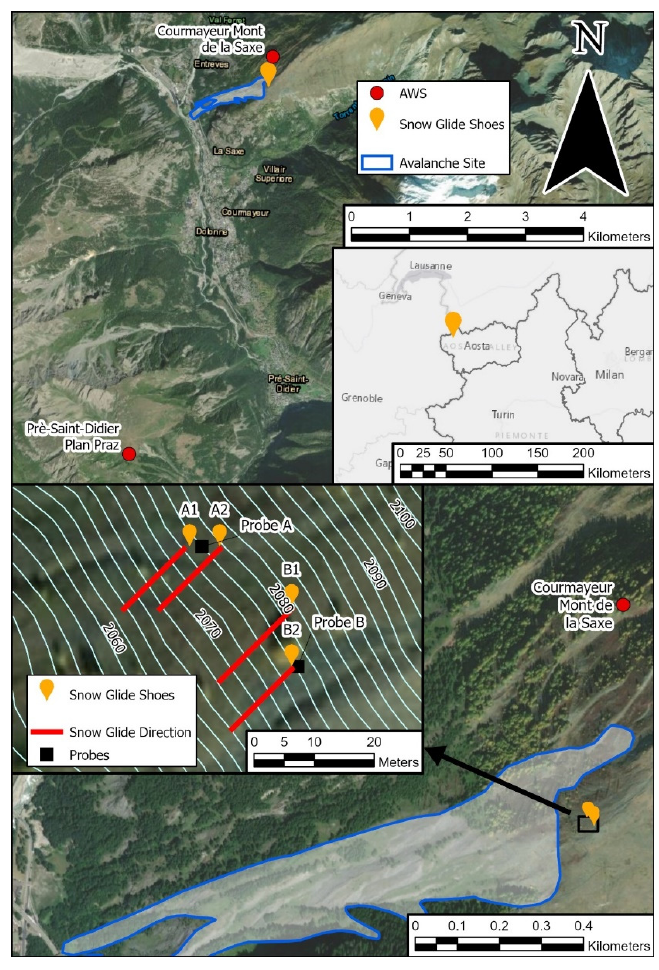
Figure 1. Location of the study area and position of the glide shoes in reference to the automatic weather stations (AWS) and the avalanche site area. Focus on the area of the glide shoes, with the glade direction and the different probe positions highlighted (snow and soil temperature and soil water content measurements).